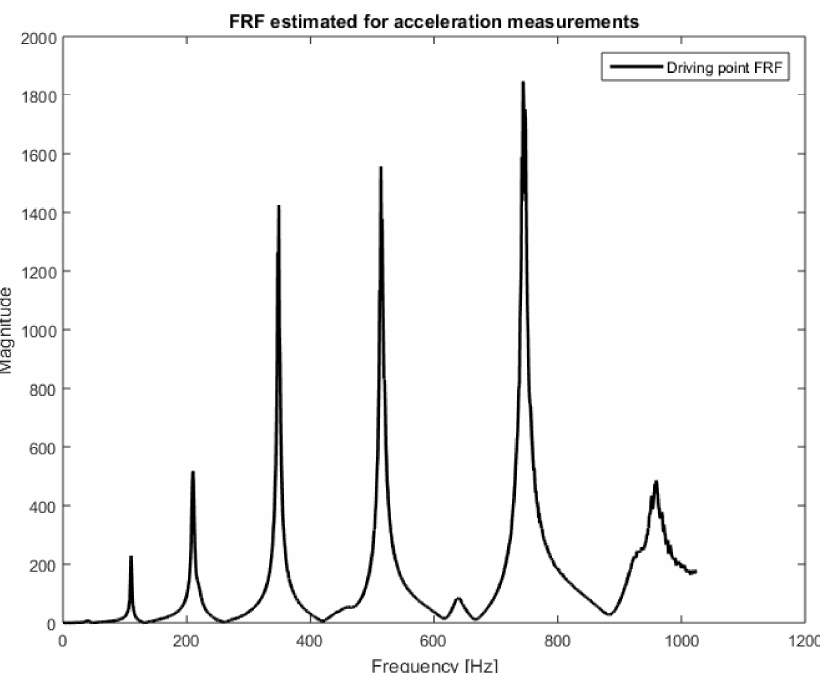
Figure 7. Driving point FRF estimated for the vibrations’ acceleration